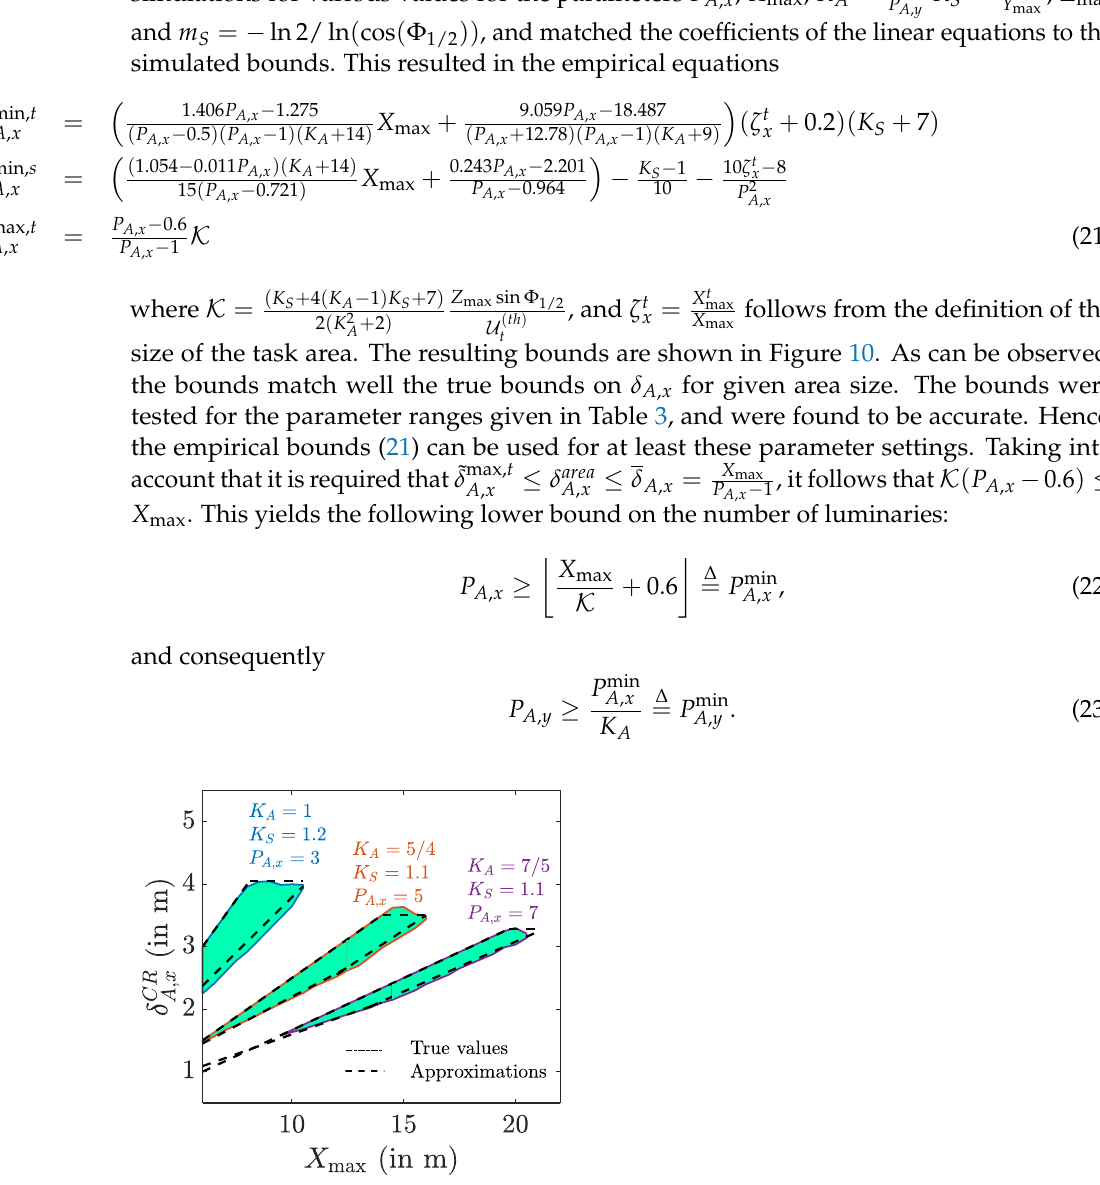
Figure 10. Boundary intervals for the spacing δ CR P A , x with ζ t x = ζ t y = 0.9, Z max = 2 m and m S =